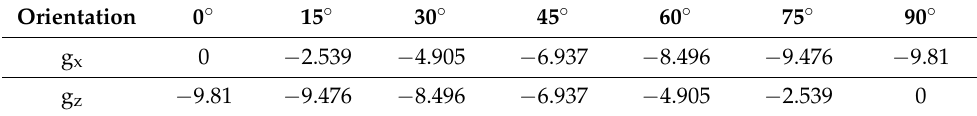
Table 1. Values of different gravitational orientation vector components (in m/s 2